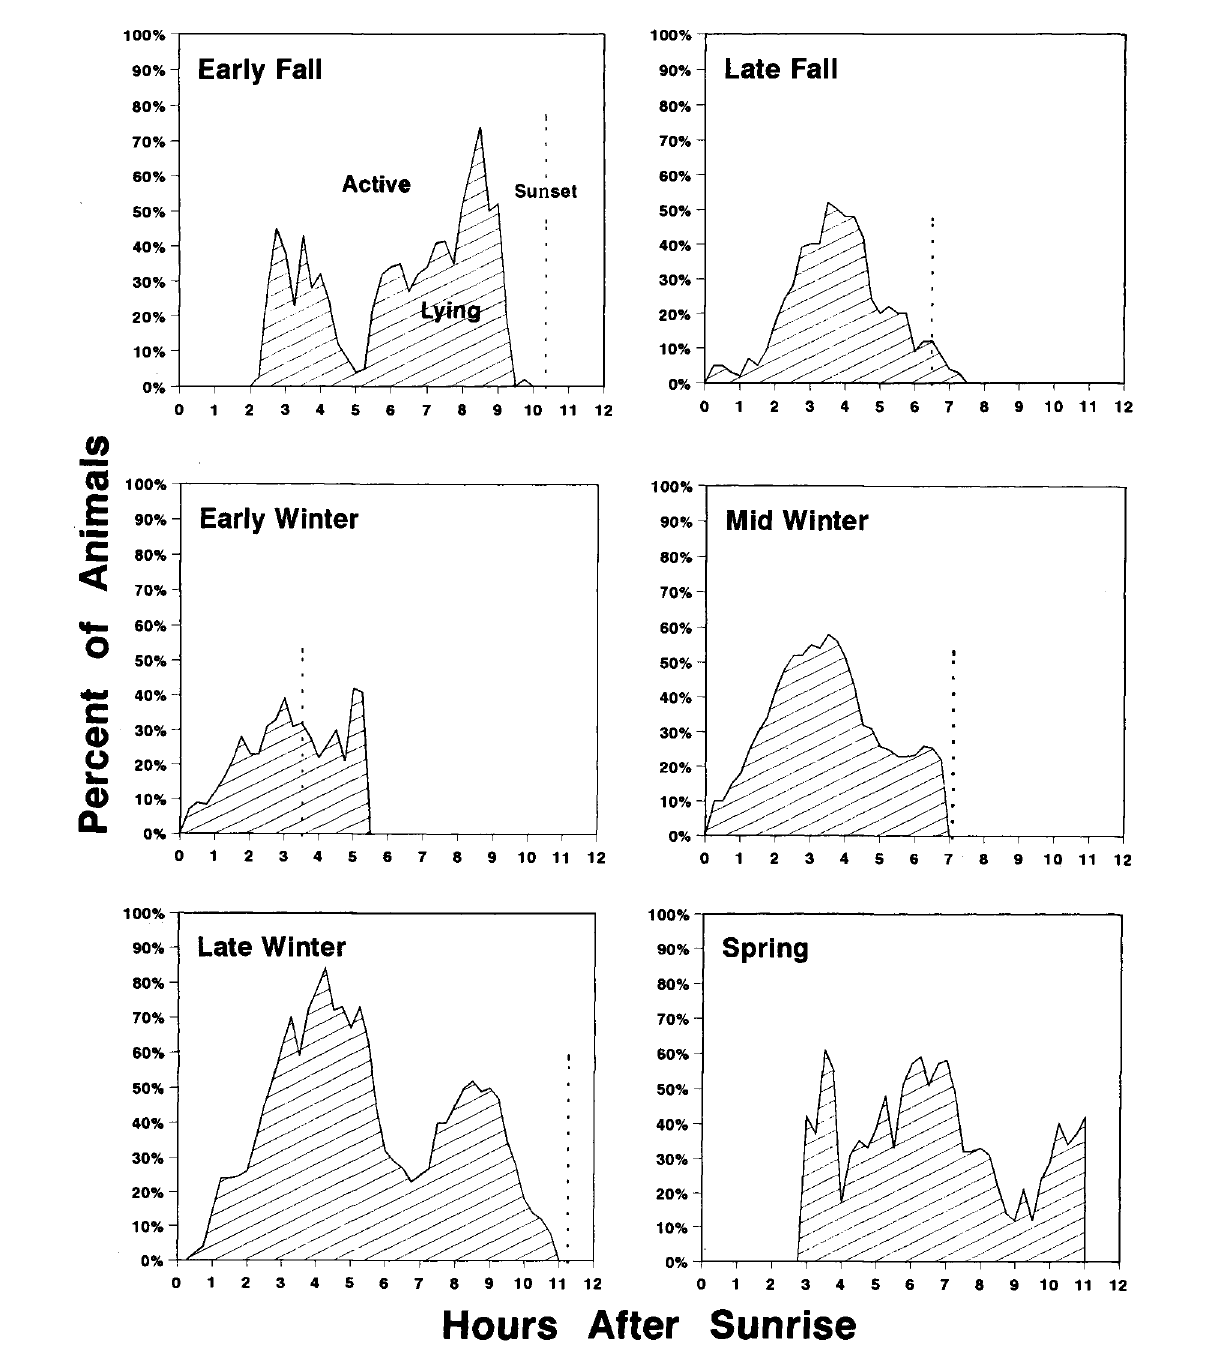
Figure 2.8. Percent of animals lying from 15 minute scans in relation to hours after sunrise for the six study periods.